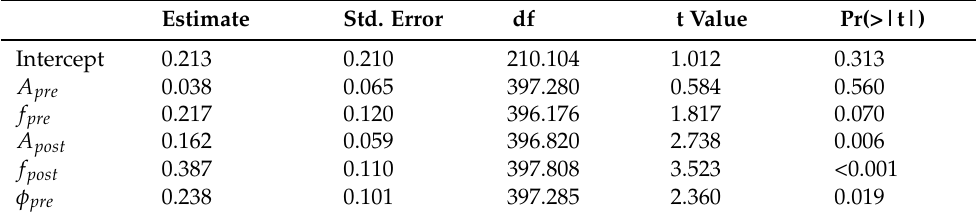
Table 3. Estimates for main effects of a mixed linear model predicting the magnitude of the eyebrow peak based on the parameters of the sinusoidal function for the pre-peak region, with a window size of 19 frames ( ≈ 630 ms), as well as the post-peak region, with a window size of 17 frames ( ≈ 570 ms). Estimate Std. Error df t Value